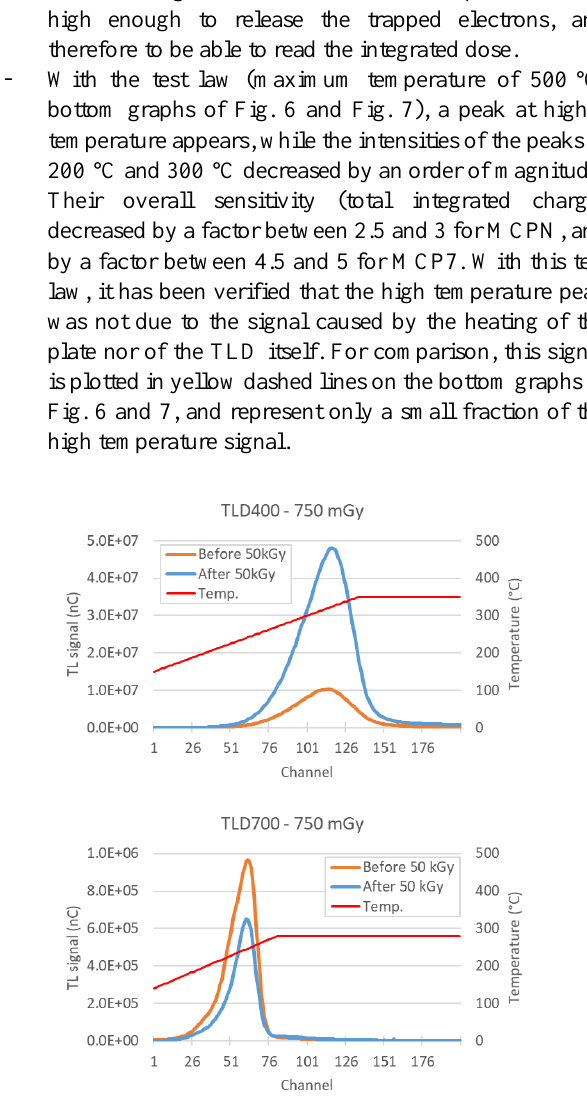
Fig. 5. Luminescence curves for TLD400 and TLD700 before and after 50 kGy exposure. Measurement after a 750 mGy irradiation in front of a 60 Co source with the standard readout protocol.